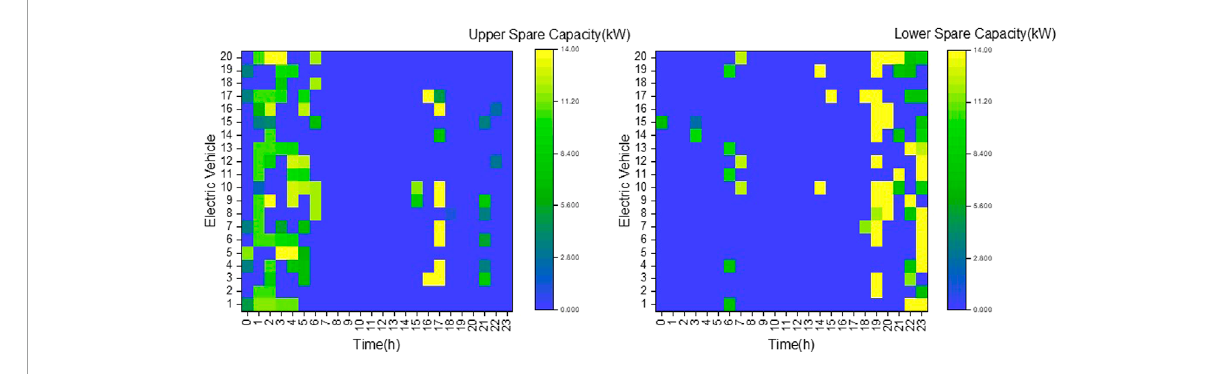
FIGURE 11 Optimization results for electric vehicle reserve capacity when there are 1,000 electric